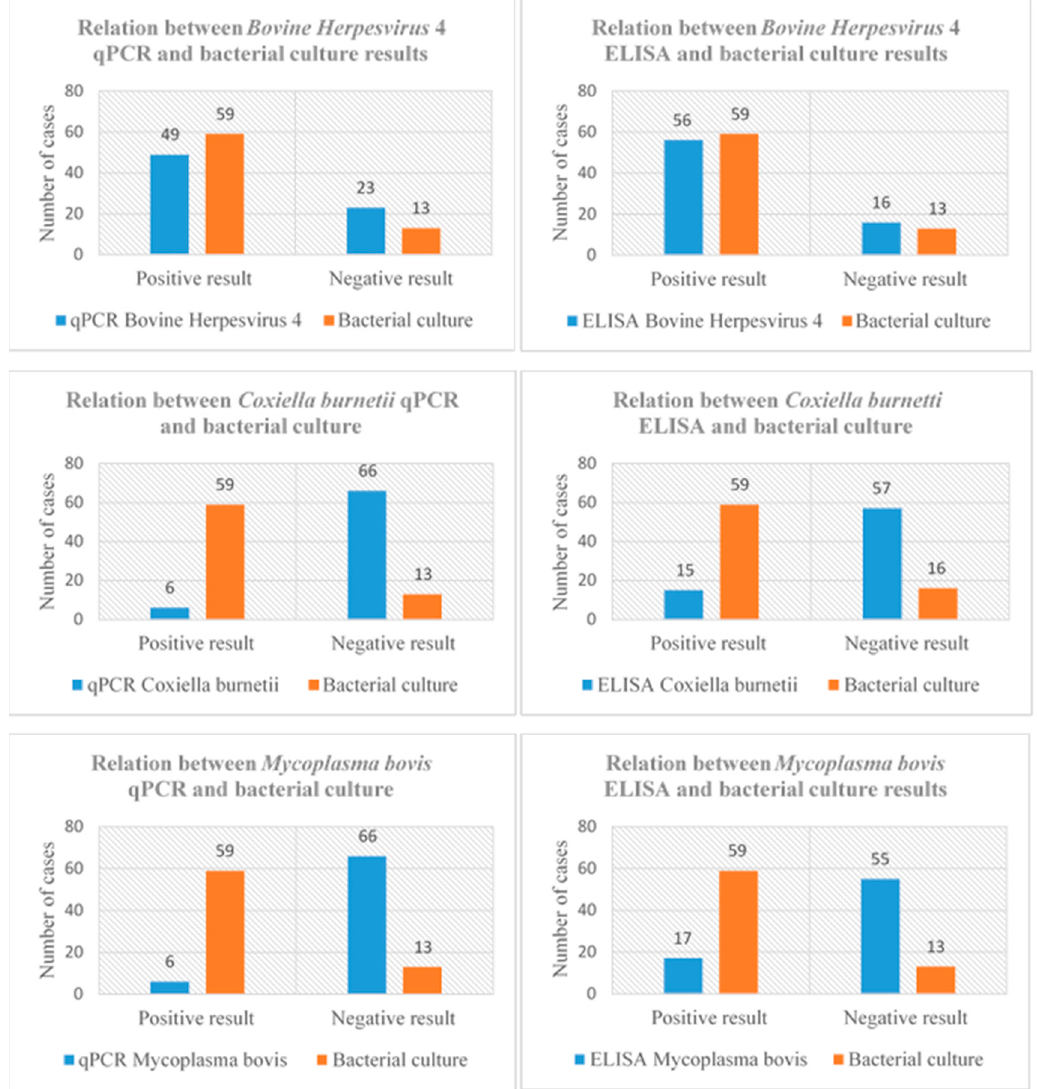
Scheme 3 : Relation between blood antibodies identified by ELISA and germs DNA identified by qPCR (peritoneal samples) for Bovine Herpesvirus 4 , Coxiella burnetii and Mycoplasma bovis , and